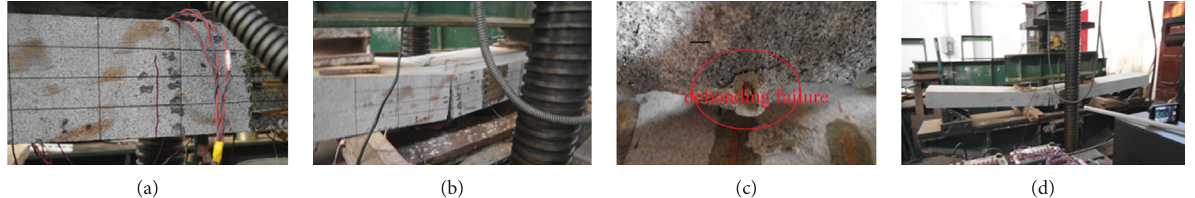
Figure 17: Failure mode of GB-1: (a) initial vertical crack; (b) fully crack; (c) steel bars crushed; (d) failure mode.